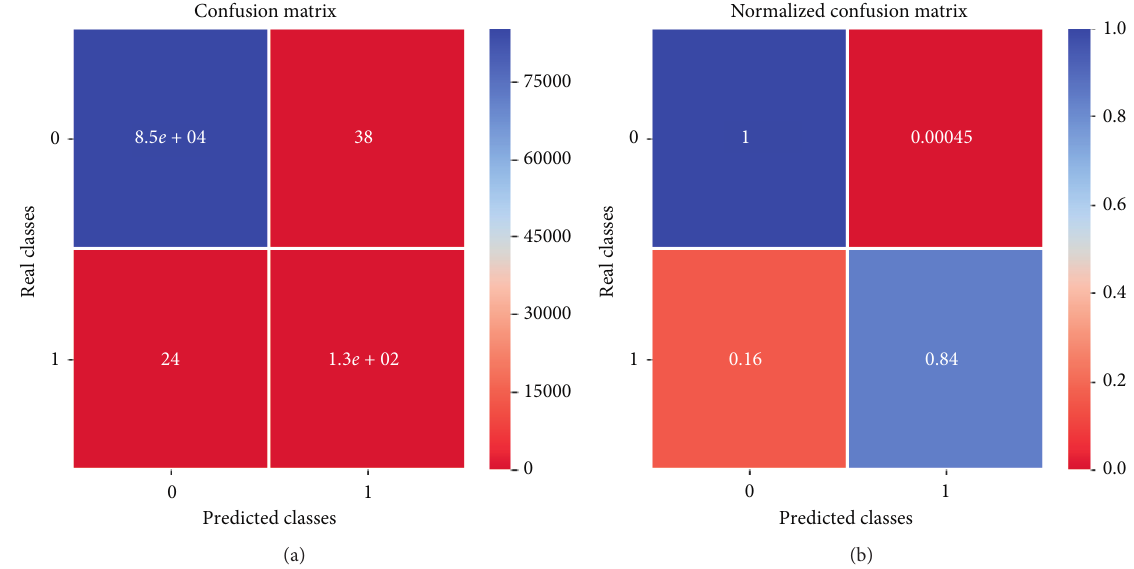
Figure 12: (a) Confusion matrix and (b) normalized confusion matrix for SVM SMOTE